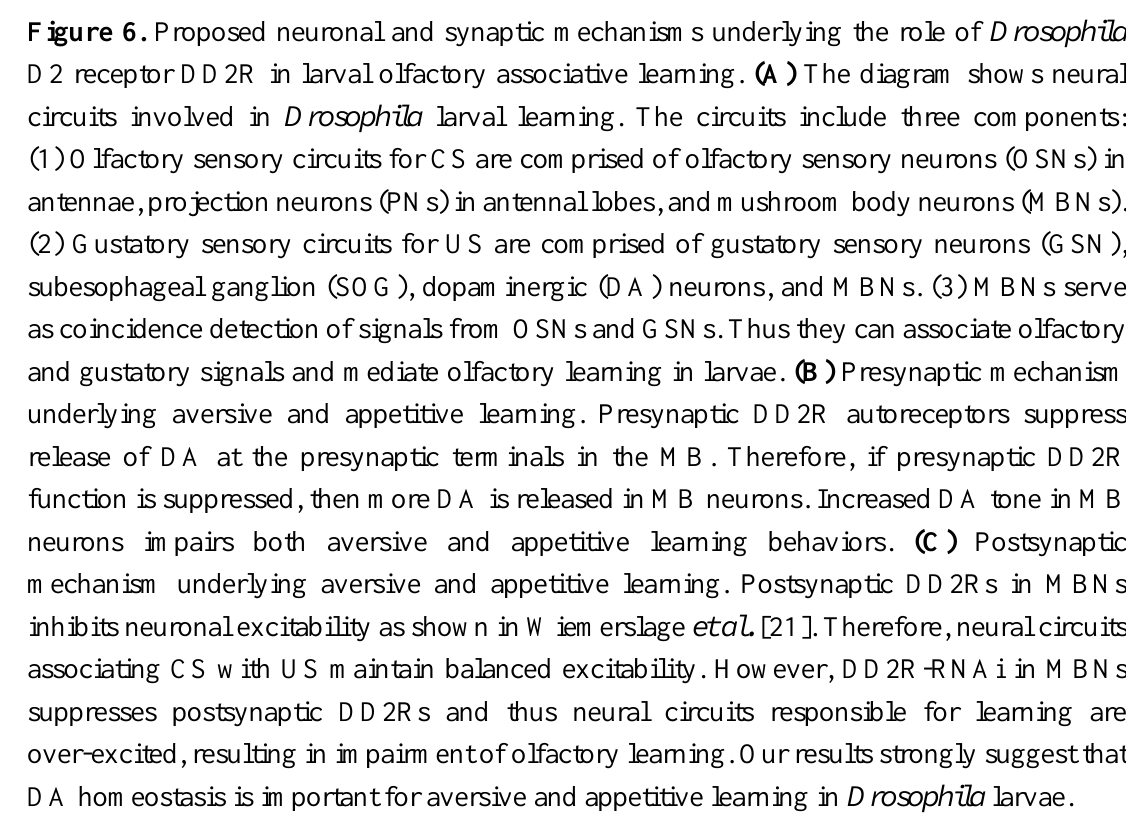
Figure 6. Proposed neuronal and synaptic mechanisms underlying the role of Drosophila D2 receptor DD2R in larval olfactory associative learning. (A) The diagram shows neural circuits involved in Drosophila larval learning. The circuits include three